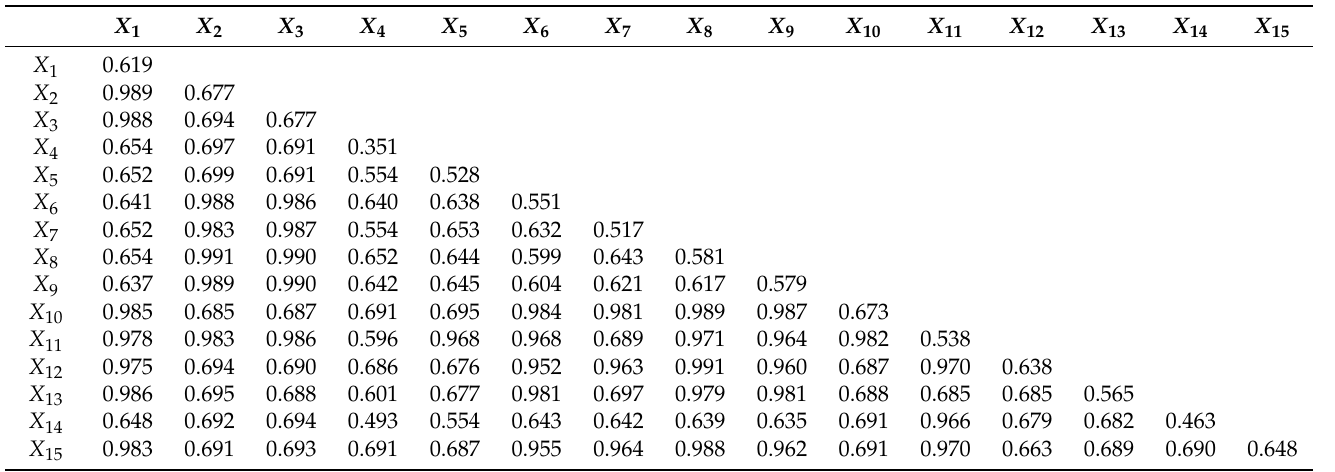
Table 5. Interactive detection analysis results of Geodetector in the YRD